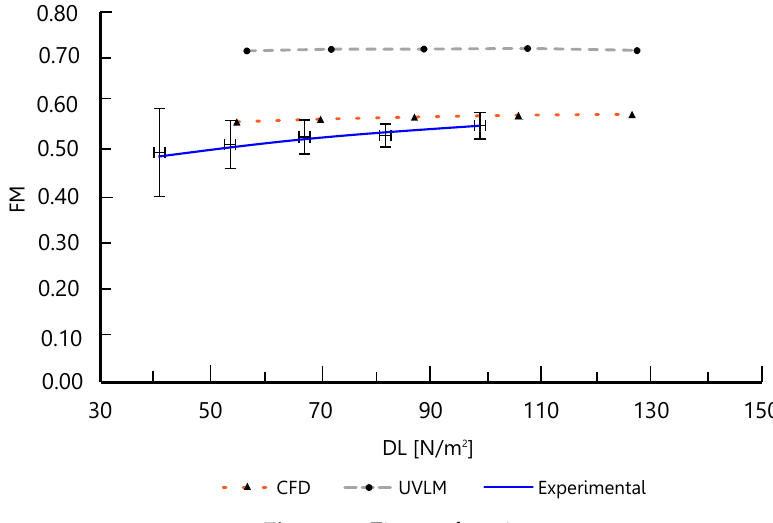
Figure 17. Figure of merit.